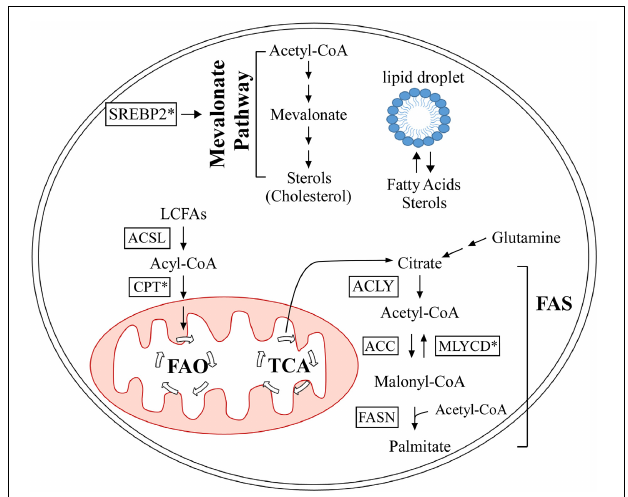
FIGURE 2 | Summary of lipid metabolism, as it pertains to the p53 family. The mevalonate pathway is out lined in the upper half. Fatty acid oxidation and synthesis are portrayed in the lower half. Proteins marked with an asterisk are regulated by the p53 family. FAO, fatty acid oxidation; TCA, tricarboxylic acid cycle; FAS, fatty acid synthesis; ACSL, long-chain acyl-CoA synthetase; CPT, carnitine palmitoyltransferase; ACLY, ATP citrate lyase; MLYCD, malonyl-CoA decarboxylase; ACC, acetyl-CoA carboxylase; FASN, fatty acid synthase; SREBP2, sterol regulatory element-binding protein